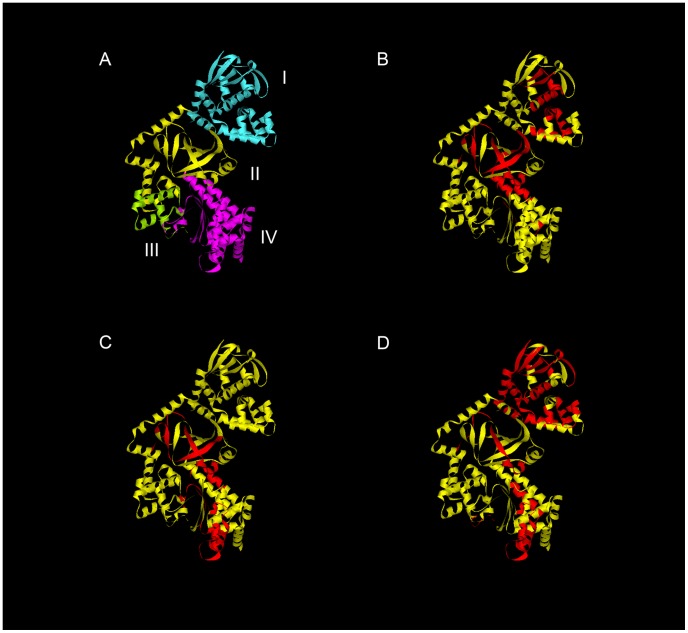
Regions HLA-DR and DQ-presented anthrax LF epitopes mapped onto the LF protein structure reveals clustering of immunogenic epitopes.The structural domains of LF protein are indicated in Roman numerals (A). Immunodominant epitopes identified in this study from mice transgenic for DRB1*0101 (B), DRB1*0401 (C), and DQB1*0302 (D) are superimposed on the LF crystal structure (Protein Data Bank accession code 1J7N). Roman numerals indicate the structural domains. Ribbon diagrams were generated using the Accelrys discovery studio client 2.5 program.